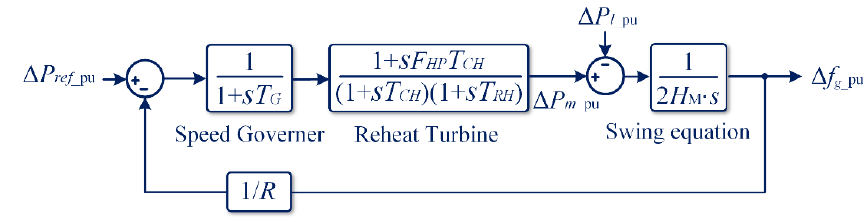
Figure 2. Primary power system frequency regulation framework.